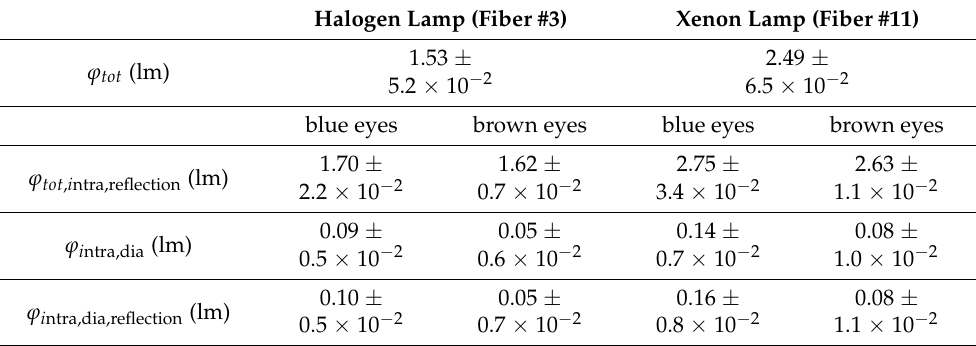
Table 2. Comparison of the luminous flux of the diaphanoscopic illumination fiber in combination with the ophthalmic xenon (fiber #11) and halogen light source (fiber #3) with and without considering the transmission of the eyewall and the intraocular reflection, depending on the iris